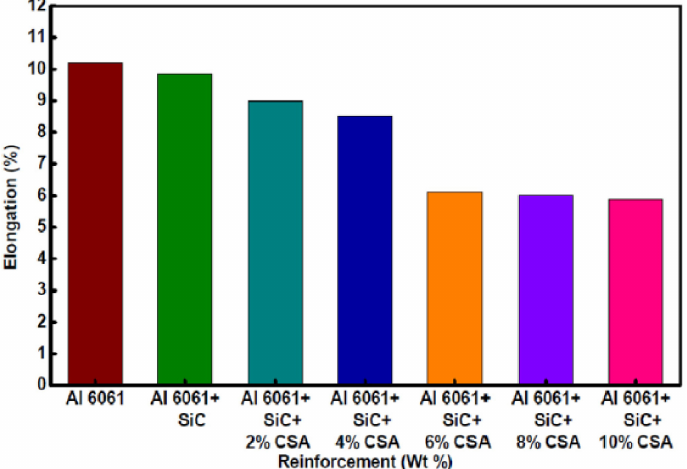
Figure 14. Elongation percentages of Al6061 alloy and its composites [125].